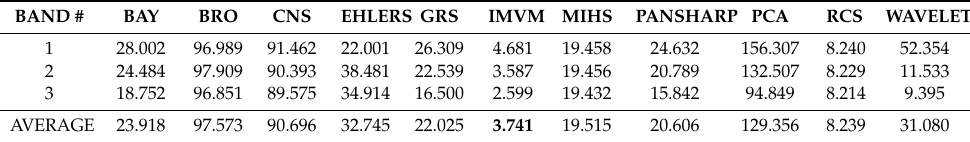
Table 5. Spectral consistency: relative average spectral error